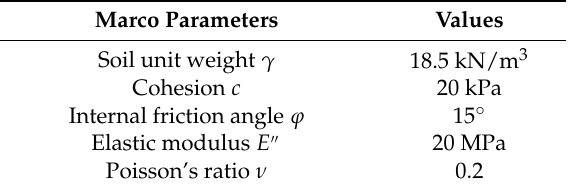
Table 2. The macro parameters of the example.